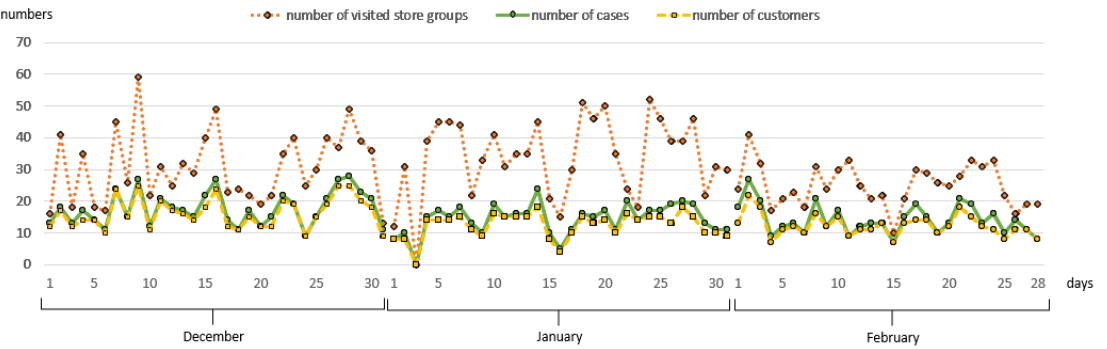
Figure 3. Number of customers and